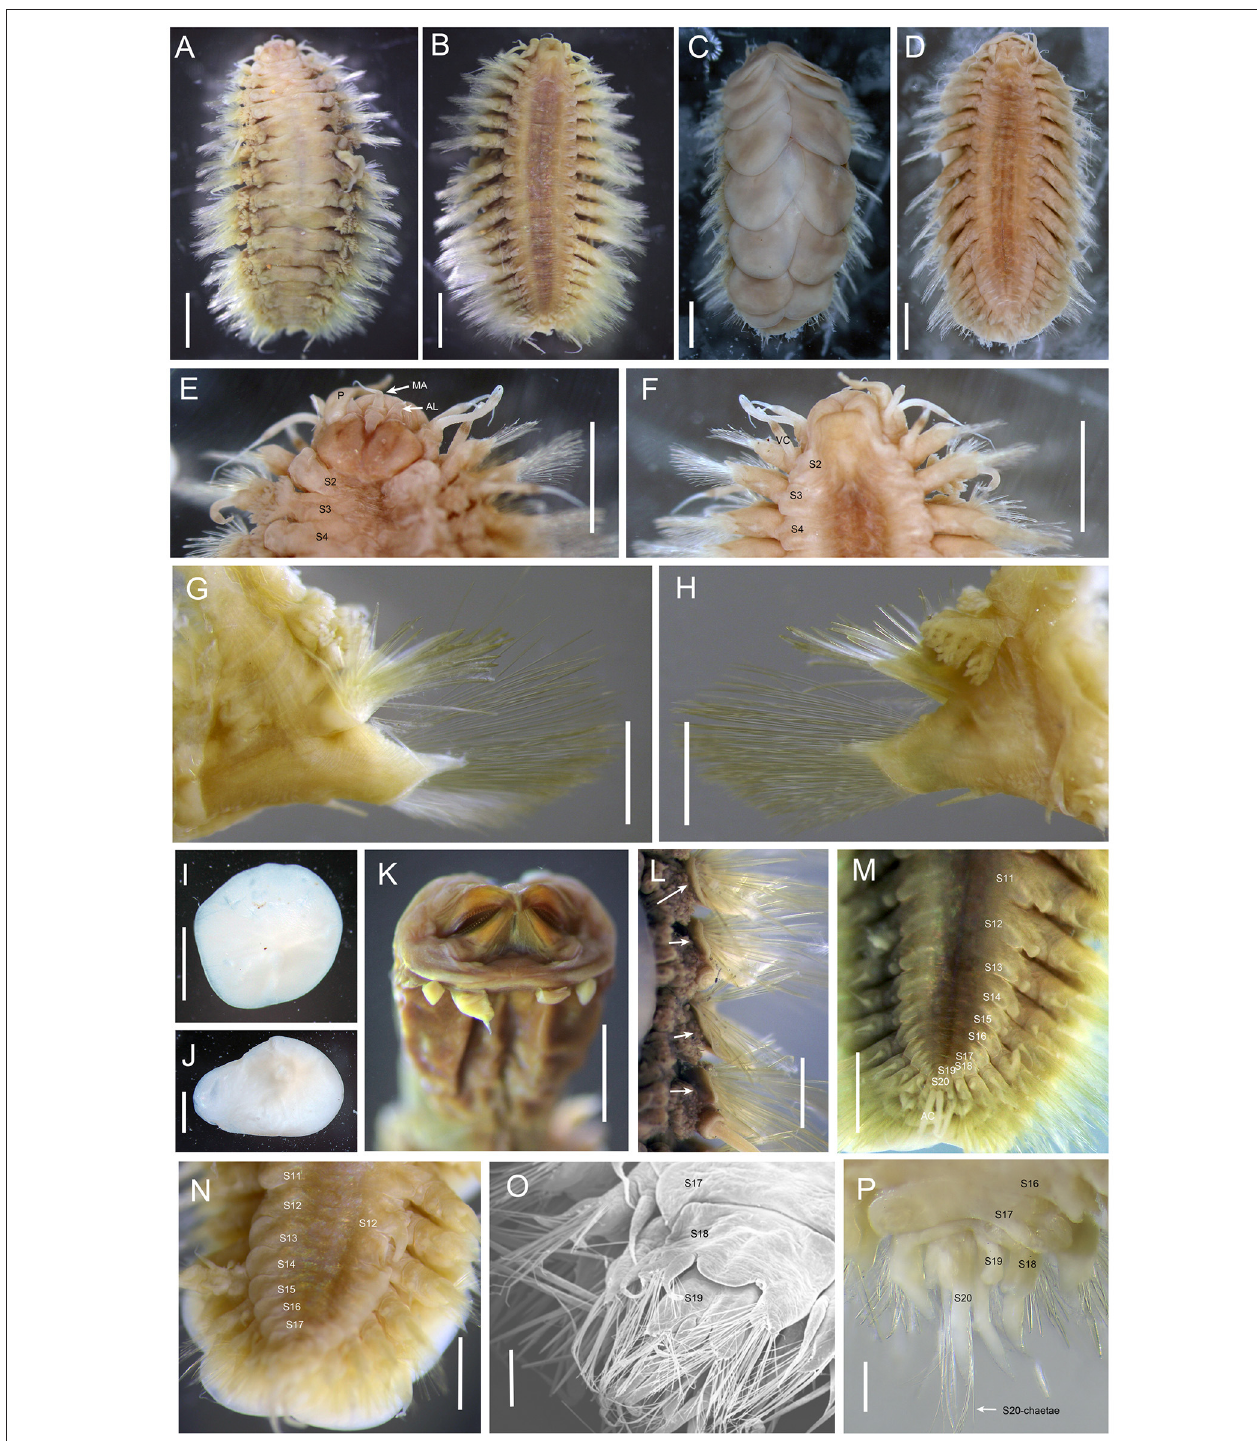
FIGURE 1 | Branchinotogluma elytropapillata sp. nov. (A,B) Paratype 1; (C,D) Holotype. E, F, I to L, Paratype 2; K, Paratype 21; M, Paratype 7; N and O, Paratype 5; P, Paratype 1. (A) , dorsal view of female. (B) , ventral view of female. (C) , dorsal view of male. (D) , ventral view of male. (E) dorsal view of anterior part. (F) ventral view of anterior part. (G) anterior view of parapodium (segment 10). (H) posterior view of parapodium (segment 10). (I,J) elytra. (K) ventral view of extended pharynx. (L) dorsal view of neuropodia show neuropodia bract (indicated by arrows). (M) ventral view of female posterior part. (N) ventral view of male posterior part. (O) the detail of posterior end of male (the same as N) from ventral side of view. (P) dorsal view of male posterior part. Scale bar: (A–D) 2mm; (E–J,L) 1mm; (K) 0.5mm; (O,P) 200 µ m. MA, medial antenna; AL, anterior lobe; VC, ventral cirri.